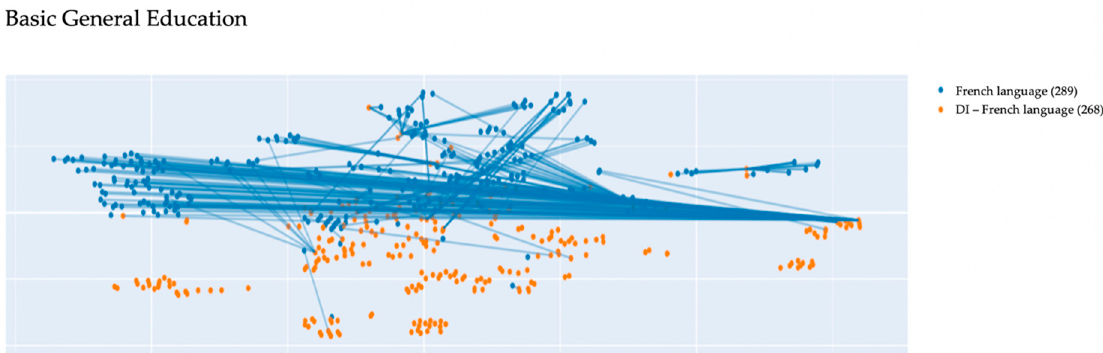
Figure 4. Semantic correlations between the didactic item titles in the topical framework and the lesson script titles in the subject French language.